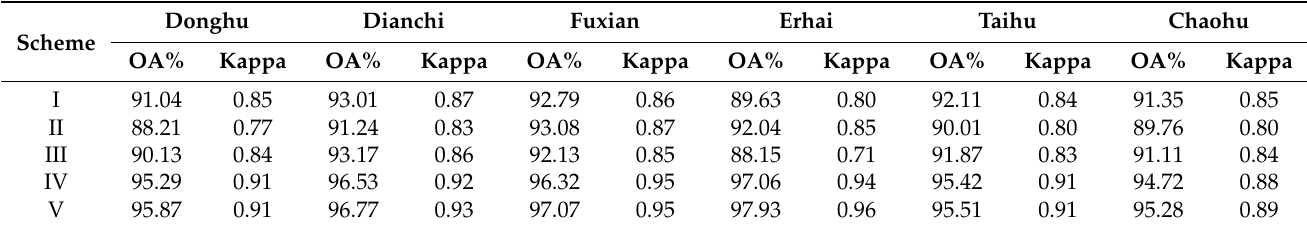
Table 4. Accuracy calculations across the six lakes.